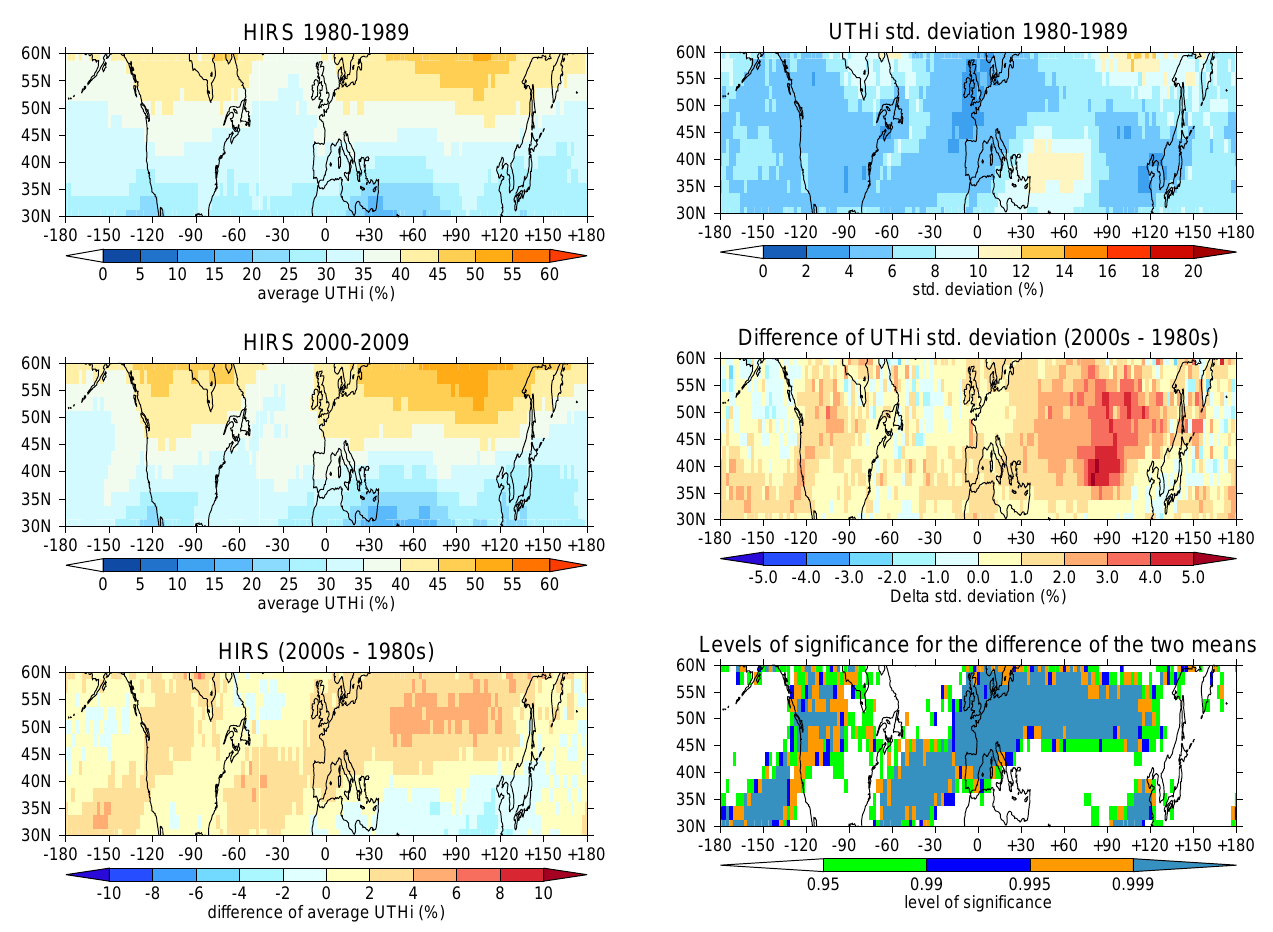
Figure 4. Top panel: map of standard deviations of upper tropo- Fig. 4. Top panel: Map of standard variations of upper tropospheric humidity based on monthly averages for the decade 1980-1989. Middle Figure 3. Decadal means of upper tropospheric humidity with re- Fig. 3. Decadal means of upper tropospheric humidity with respect to ice for the decades 1980-1989 and 2000-2009 and the difference of panel: Map of the change of these standard variations between 2000-2009 and 1980-1989. Bottom panel: Statistical significance values for spheric humidity based on monthly averages for the decade 1980– thesemeansfromallavailableHIRSobservationsduringtherespectiveperiods.Spatialresolutionis 2 . 5 ◦ × 2 . 5 ◦ andshownisthezone30 ◦ N spect to ice for the decades 1980–1989 and 2000–2009 and the dif- the difference of two decadal means of UTH i based on t-tests with unequal variances for each pixel. Resolution as in figure 3. 1989. Middle panel: map of the change of these standard variations to 60 ◦ N. ference of these means from all available HIRS observations during between 2000–2009 and 1980–1989. Bottom panel: statistical sig- the respective periods. Spatial resolution is 2 . 5 ◦ × 2 . 5 ◦ and shown nificance values for the difference of two decadal means of UTH i is the zone 30–60 ◦ N. based on t tests with unequal variances for each pixel. Resolution as in Fig.